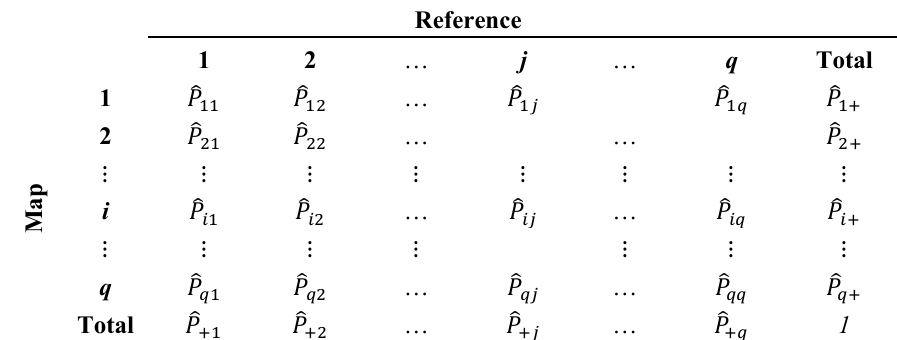
Table 9. Adjusted error matrix of estimated area